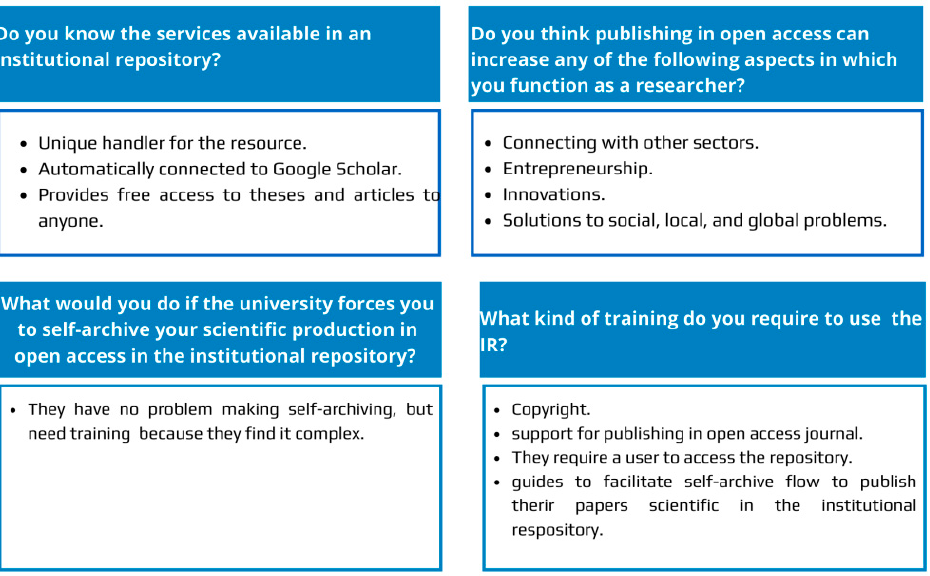
Figure 3. Results of the perceived usefulness indicator. (Own